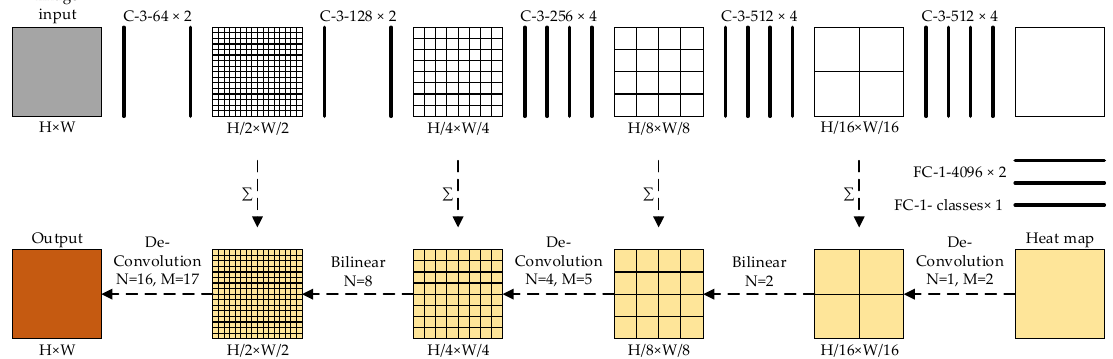
Figure 4. Up-sampling with bilinear and de-convolution operations. H indicates the height of the feature maps, W indicates the width of the feature maps. N indicates the pixel side length of the feature maps. M indicates the size of the convolutional kernel in de-convolution.